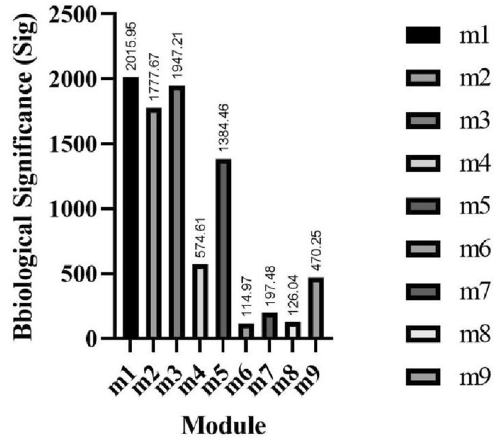
Figure 4. The biological significance of nine gene modules identified by GCNA-Kpca algorithm. This figure was drawn with GraphPad Prism 9.